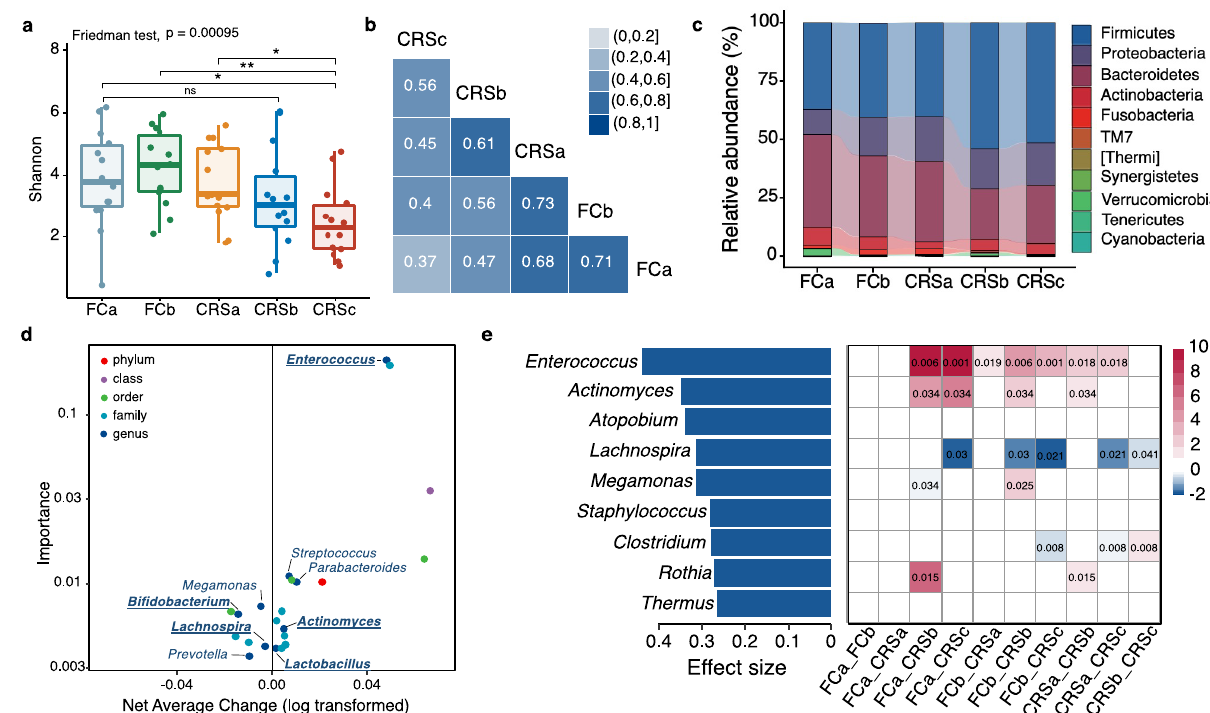
Fig. 2 | Changes of microbial composition during CAR-T therapy in MM patients. a Shannon diversity indicesofgut microbiome acrossCAR-T stages in all myeloma patients. Differential tests by Friedman ’ s tests and two-tailed Wilcoxon rank-sum tests for 10 pairwise comparisons of the fi ve timepoints ( n =14). Bon- ferroni correction was applied for multiple testing; *FDR<0.05, **FDR<0.01. For FCa versus CRSc, adjusted p =0.023; FCb versus CRSc, adjusted p =0.009; CRSa versus CRSc,adjusted p =0.017. Boxplots indicate the median (thick bar), fi rst and third quartiles (lower and upper bounds of the box, respectively), lowest and highestdatavaluewithin1.5timestheinterquartilerange(lowerandupperbounds of the whisker). b Pairwise Spearman correlation of OTU-level bacterial abundance across different timepoints. Rho value for each signi fi cant correlation is labeled inside box. c Stacked bar plot of mean phylum-level phylogenetic composition of bacterial taxa in myeloma patients across different therapy stages. d Signi fi cant